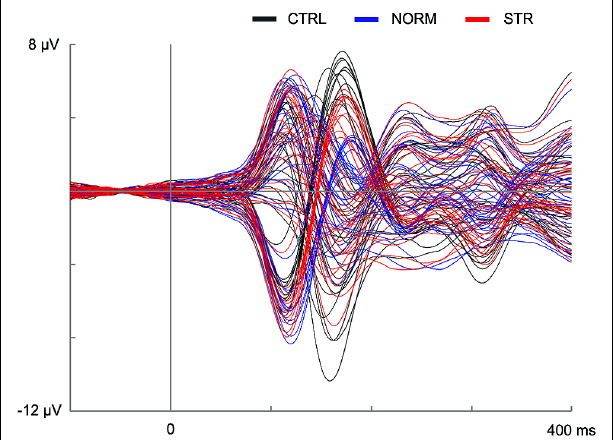
FIGURE 3 | Event-related potential waveforms for all channels in the CTRL (black lines), NORM (blue lines), and STR (red lines) conditions. The vertical line at time point 0 marks the onset of the test